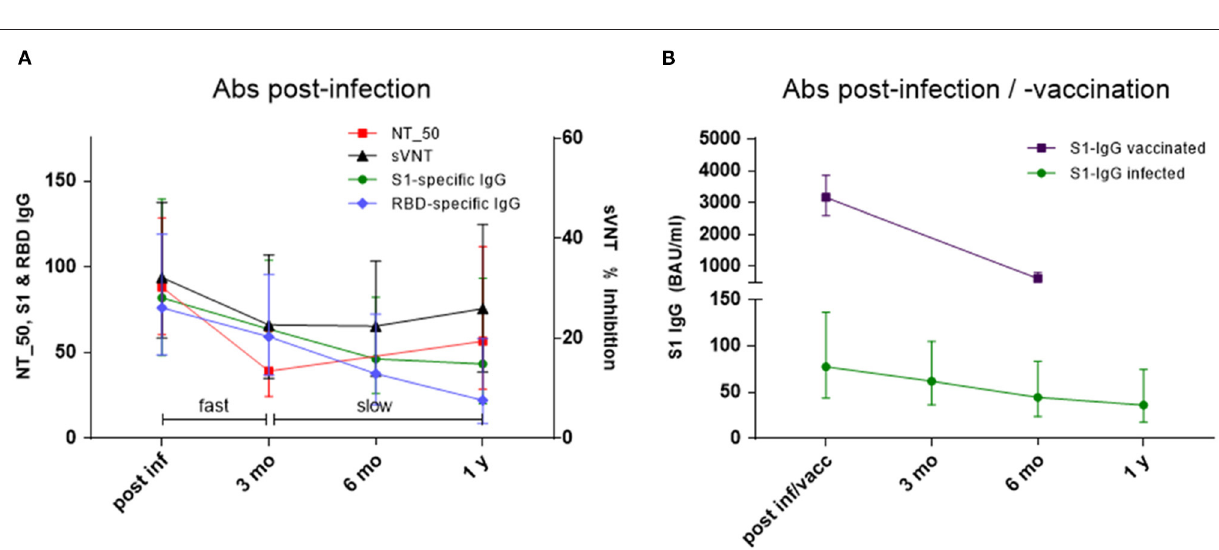
FIGURE 2 | (A,B) Relationship between log transformed Ab concentrations measured 3 months and 1 year post infection for (A) NT_50 titers 1:x (Spearman correlation coefficient, and p-value for the test against r s = 0: r s = 0.861, p = 0.0006), and (B) S1-specific IgG in BAU/ml ( r s = 0.846, p = 0.0009). Gray lines indicate negative cut-off, red lines indicate potential thresholds for persistence at 3 months, and green lines indicate retained Ab concentrations after 1 year.